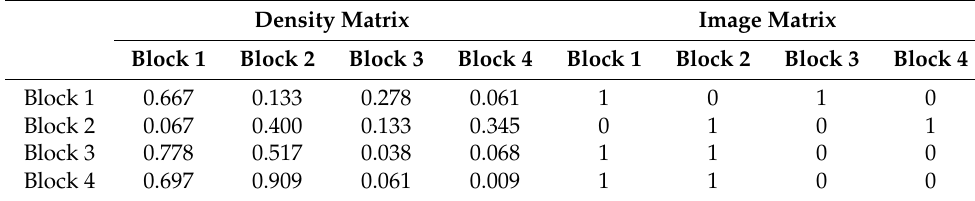
Table 4. Density matrix and image matrix of all blocks. Density